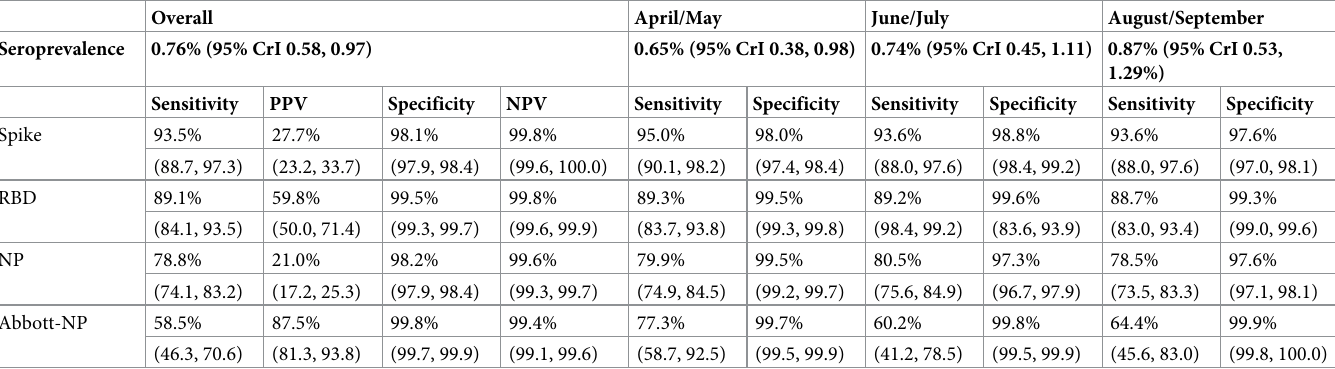
Table 3. Seroprevalence and assay characteristics overall and bi-monthly based on the Bayesian latent class analysis with informative priors. Overall